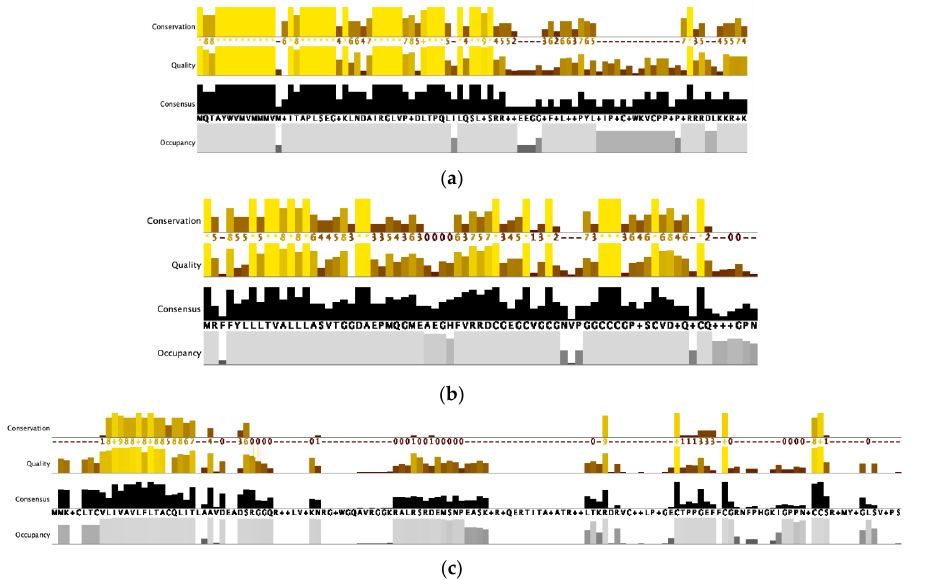
Table 2. Principal component analysis plots.